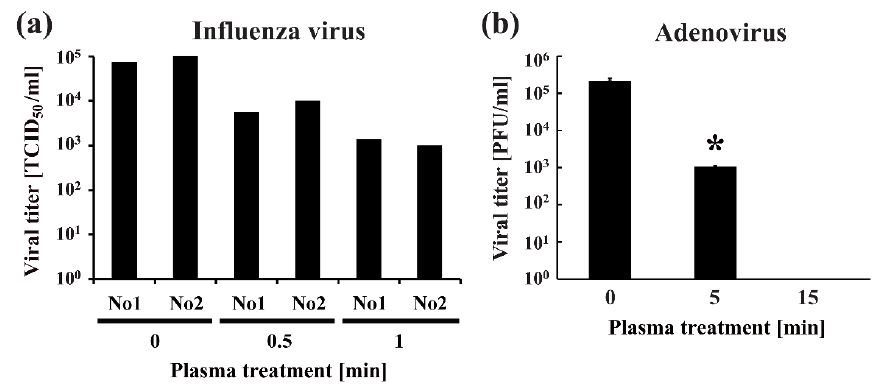
Figure 3. Direct plasma treatment inactivates viruses. ( a ) Viral titers of median tissue culture infectious dose (TCID 50 ) per ml were calculated in duplicate (No 1 and No 2) for the influenza virus. The TCID 50 values reduced after treatment with low-pressure nitrogen gas plasma using the BLP-TES